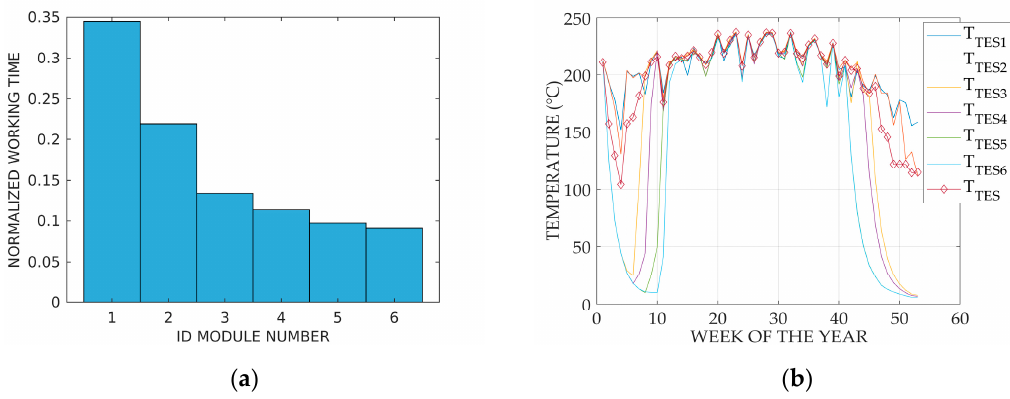
Figure 10. ( a ) Normalized working time for each module; ( b ) temperature trends of the six sub-LHTES modules and the single storage over the year.